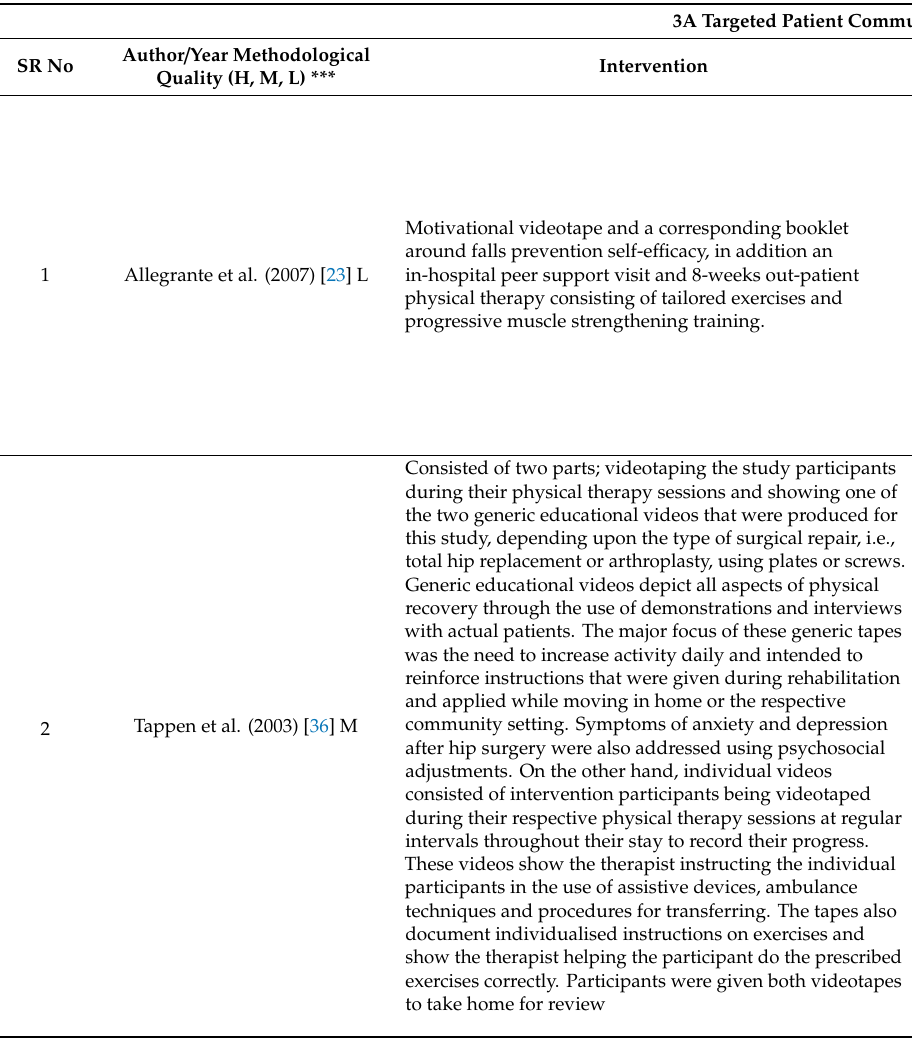
Table 3. Narrative